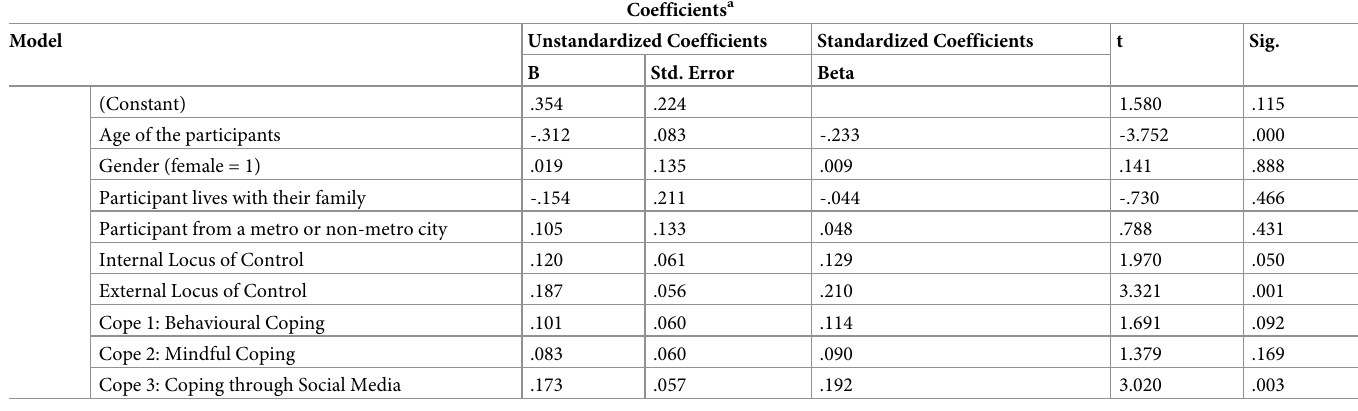
Table 6. Linear regression.